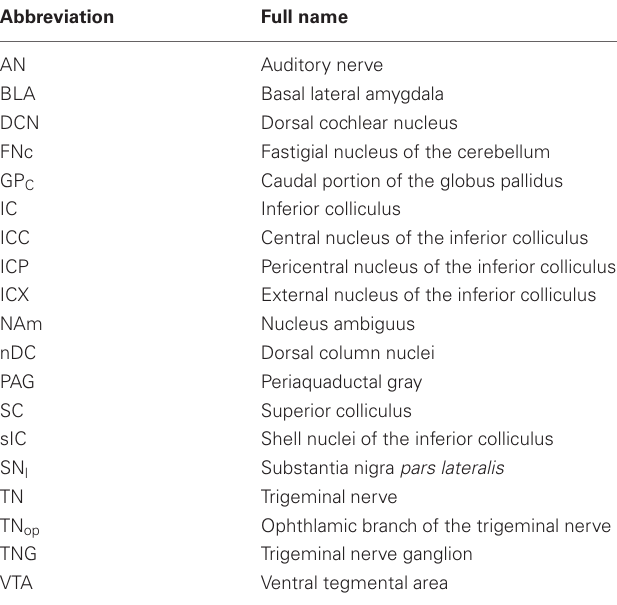
Table 1 | List of anatomical